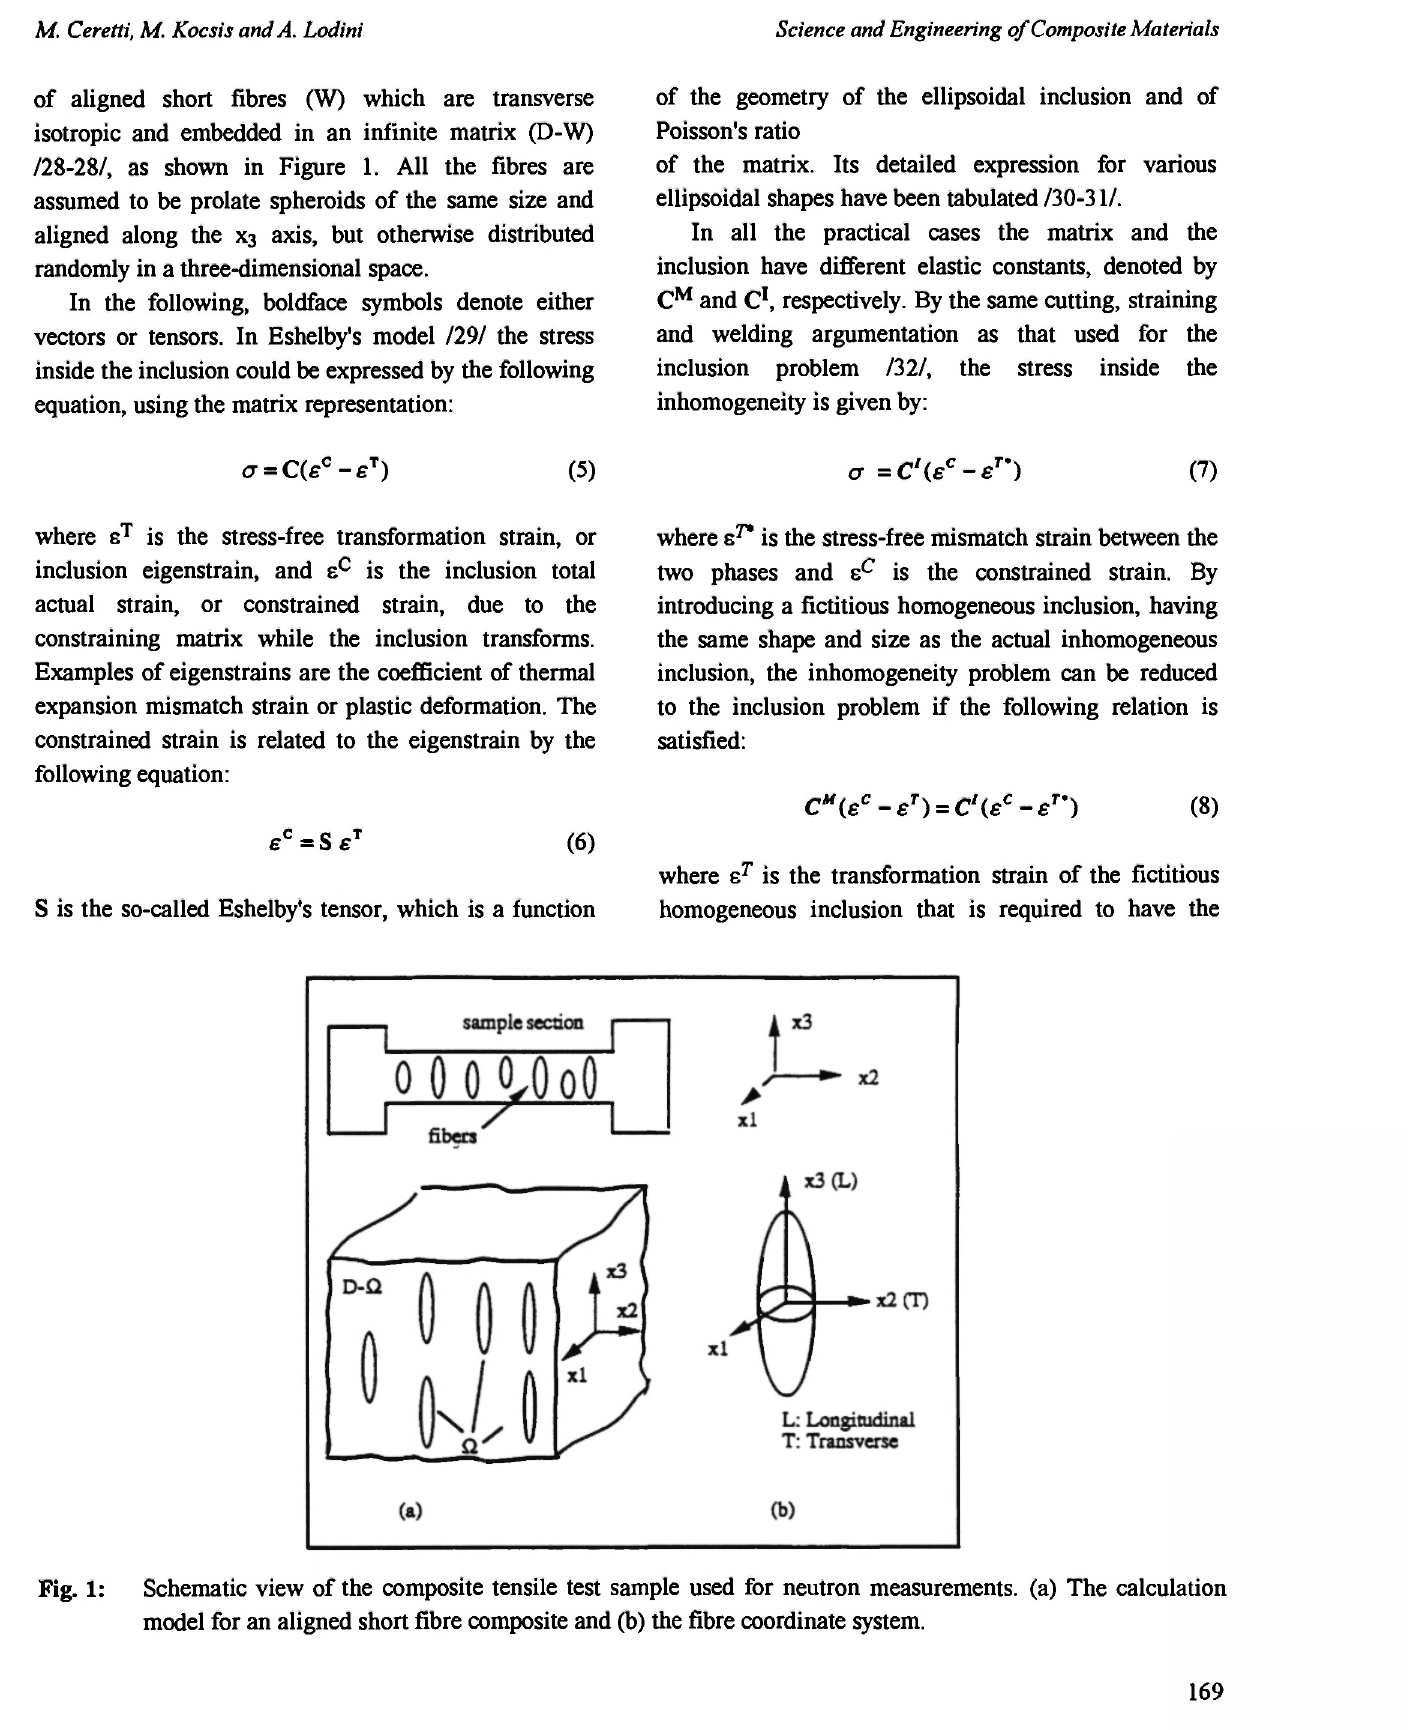
Schematic view of the composite tensile test sample used for neutron measurements, (a) The calculation model for an aligned short fibre composite and (b) the fibre coordinate